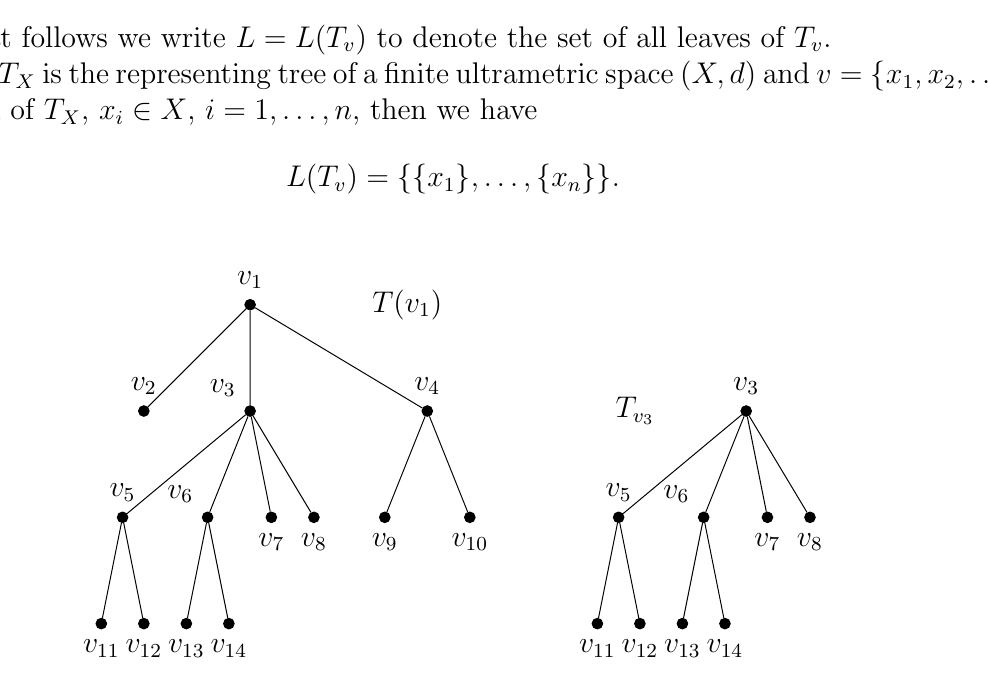
Figure 3: The rooted tree T Here L ( T